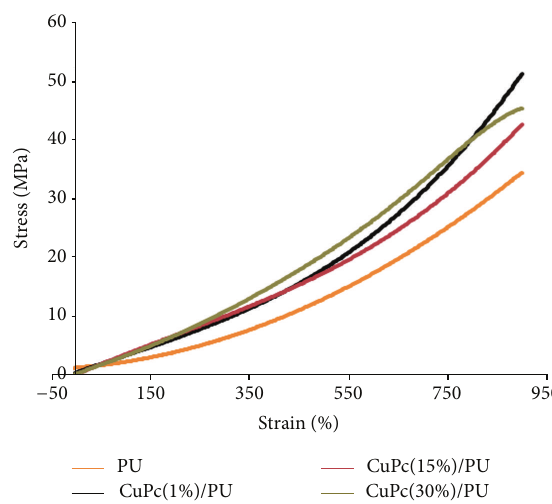
Figure 4: Stress-Strain behavior for PU and CuPc/PU composites.